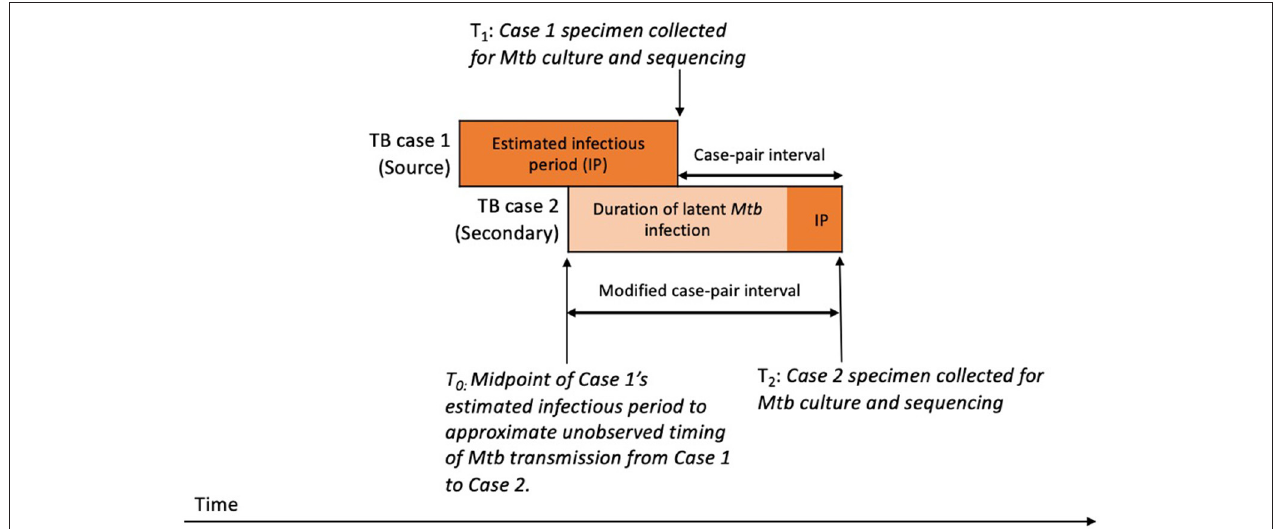
FIGURE 2 | Schematic timeline of infection and transmission of Mycobacterium tuberculosis ( Mtb ) infection in a hypothetical case pair to illustrate timing of case-pair interval calculations a . a The case-pair intervals estimate the duration of latent Mtb infection and disease of the secondary patient or the period during which SNPs are expected to accumulate in the sampled Mtb genomes for differentiating source and secondary patients’ isolates. We calculated the case-pair interval as the observed time difference between specimen collection dates for the source–secondary case pair (T 1 to T 2 ). However, this does not include a portion of the secondary patient’s Mtb infection before specimen collection for the first patient. To account for this portion, we also calculated a modified case-pair interval, which we defined as the time between the midpoint of the source patient’s estimated TB infectious period and the sample collection date of the secondary patient (T 0 to T 2